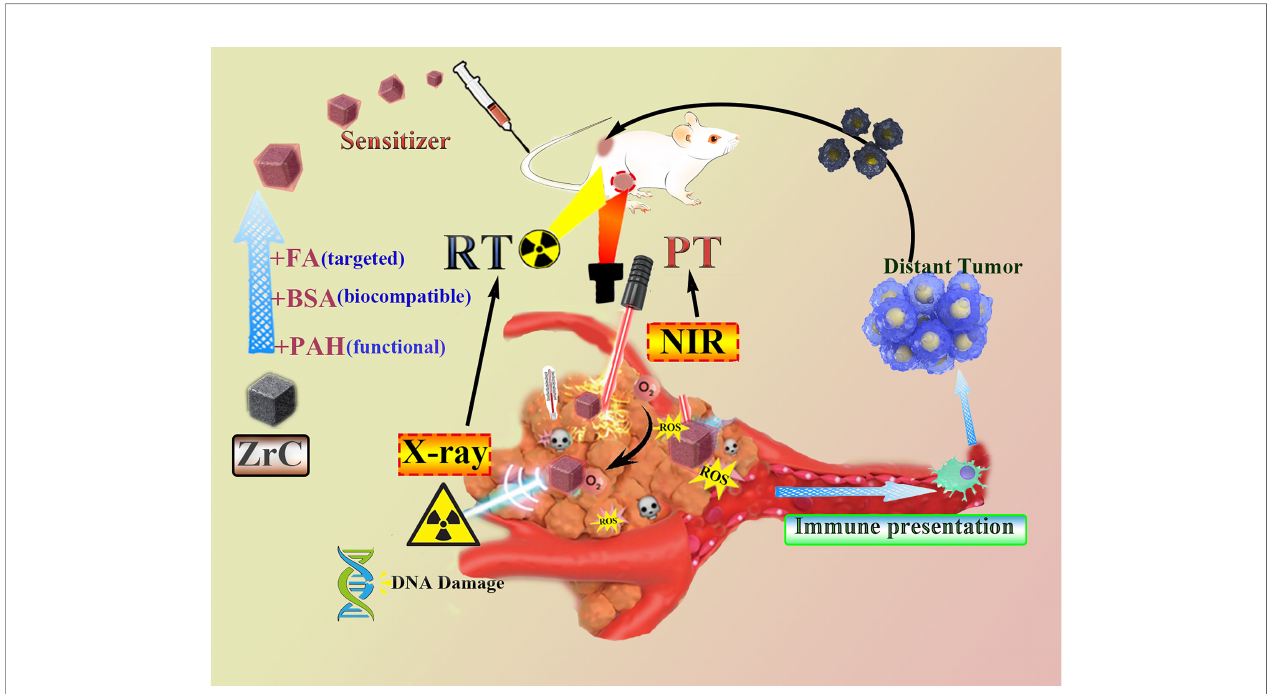
SCHEME 1 | Scheme diagram of radiation therapy combined phototherapy process of this